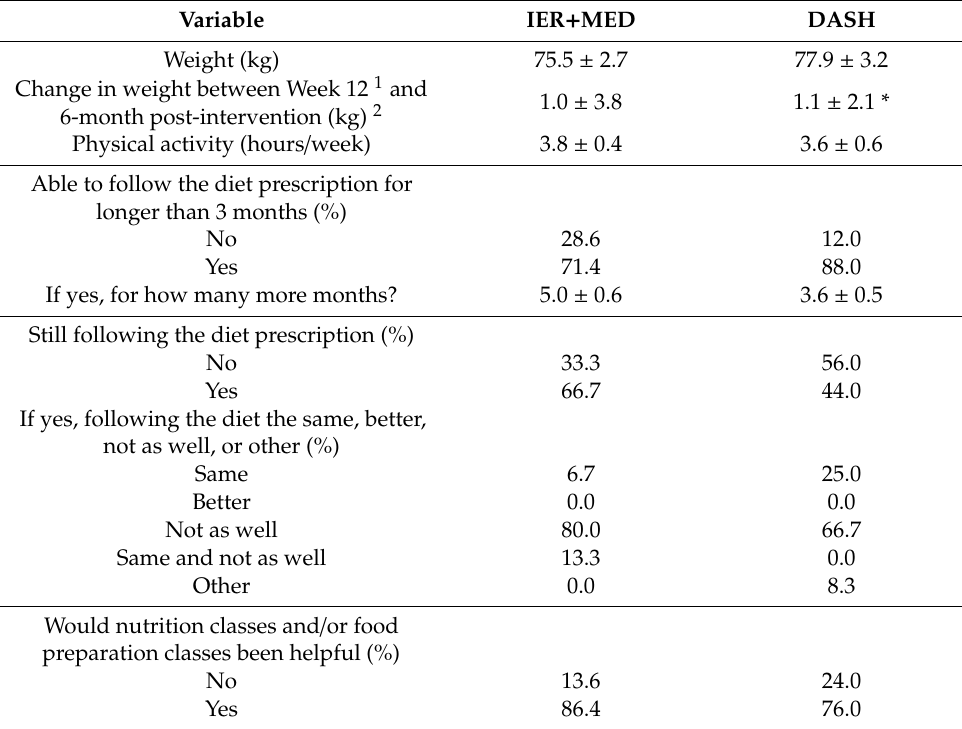
Table 5. Self-reported data collected during the 6-month post-intervention telephone interview for participants in the IER + MED group ( n = 22) and the DASH group ( n = 26), who completed the